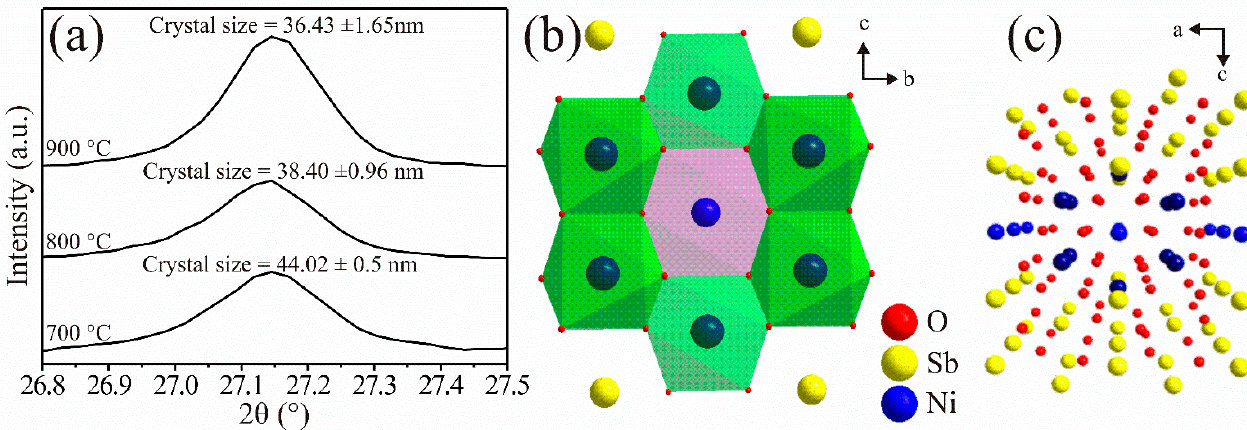
Figure 4. ( a ) Crystallite size as a function of the calcination temperature, ( b ) projection of an octahedral hole, ( c ) atomic ordering of the trirutile-type NiSb 2 O 6 ’s structure.